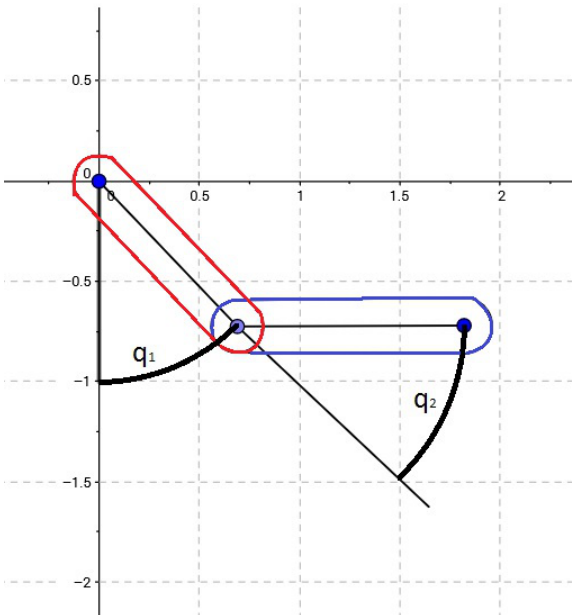
Figure 1. Image of a simulated acrobot. This robot has a passive actuator on the first joint (on red). The second joint is on blue. The angle of the first link is called q 1 and the angle of the second link is q 2